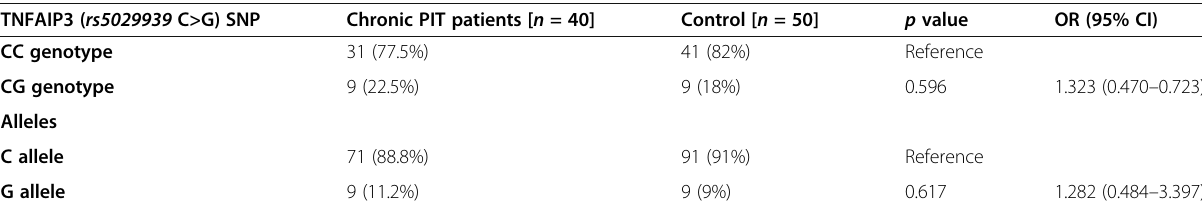
Table 3 Comparison of TNFAIP3 ( rs5029939 C > G ) genotype distribution and allele frequency between chronic PIT patients and